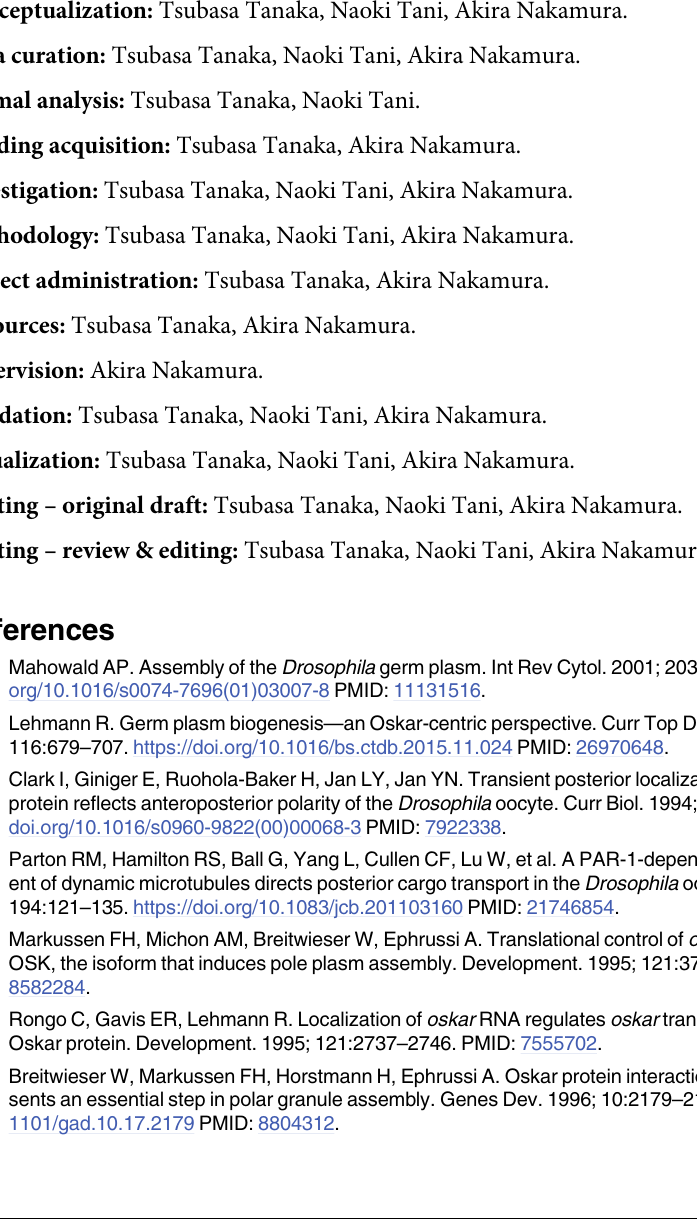
S1 Data. All individual numerical data in the different figure panels. (XLSX) S1 Raw Images. Full gel and blot images.